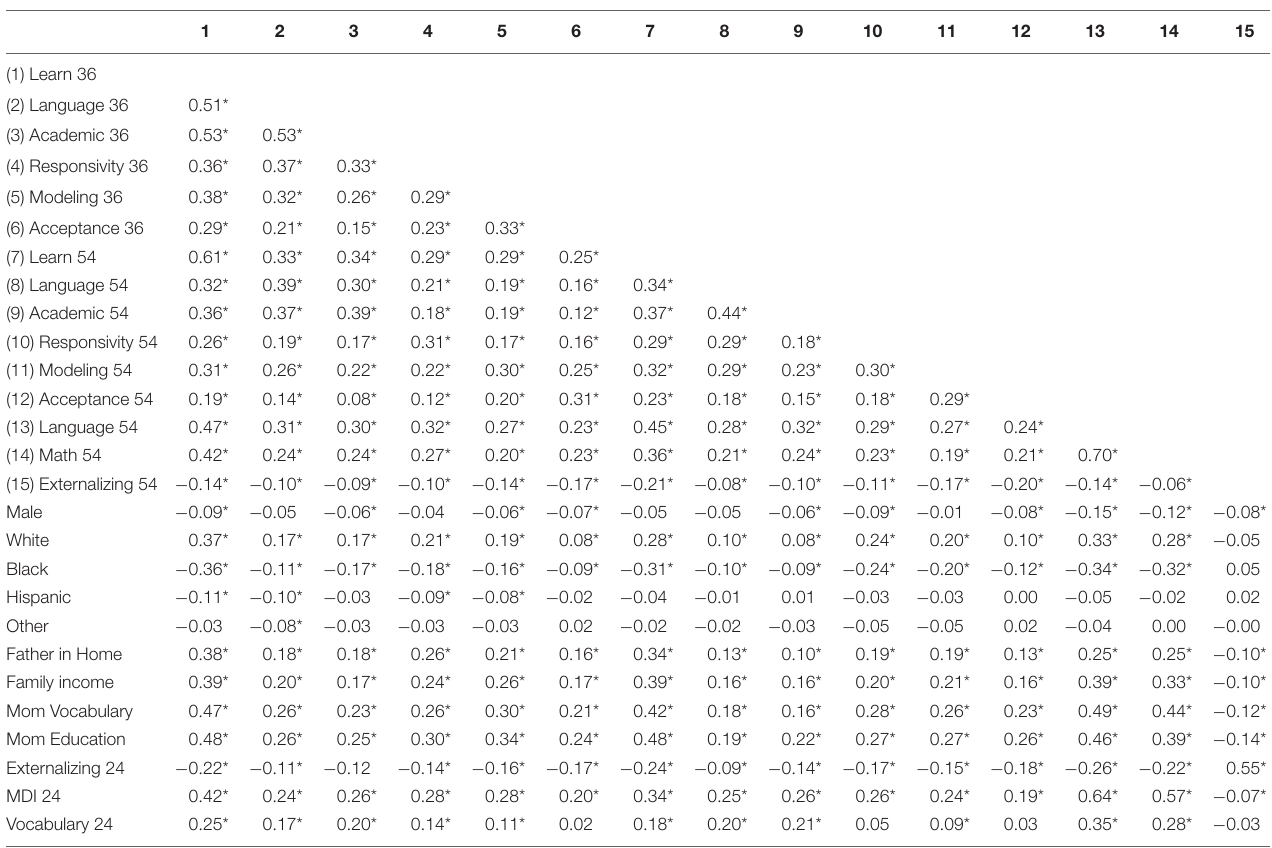
TABLE 2 | Correlations for variables included in the